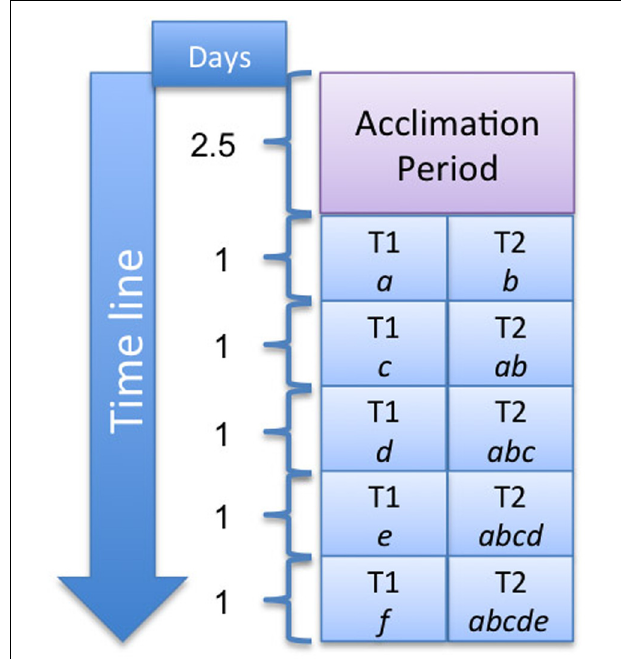
FIGURE 2 | Description of Experiment B. The fish number is kept constant, only one fish, in tank 1. Each day the fish that had been for 1 day in tank 1 was transferred to tank 2. Thus, the number of fish in tank 2 increased by one individual every day. T1 and T2 indicate tank 1 and 2, respectively. The number of days the activity lasted is shown under “Days” on the left; each letter within the tanks, a , b , c , d , e, and f refer to an individual fish.